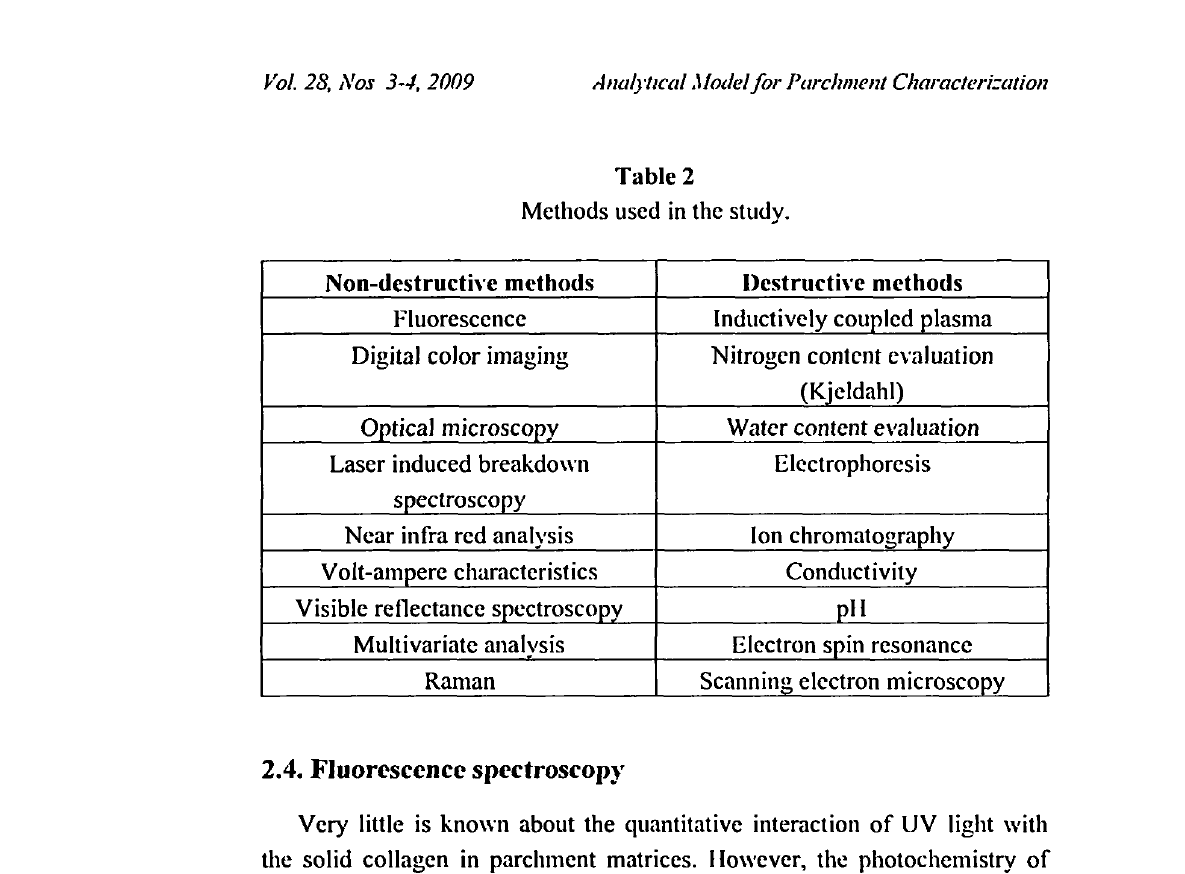
Methods used in the